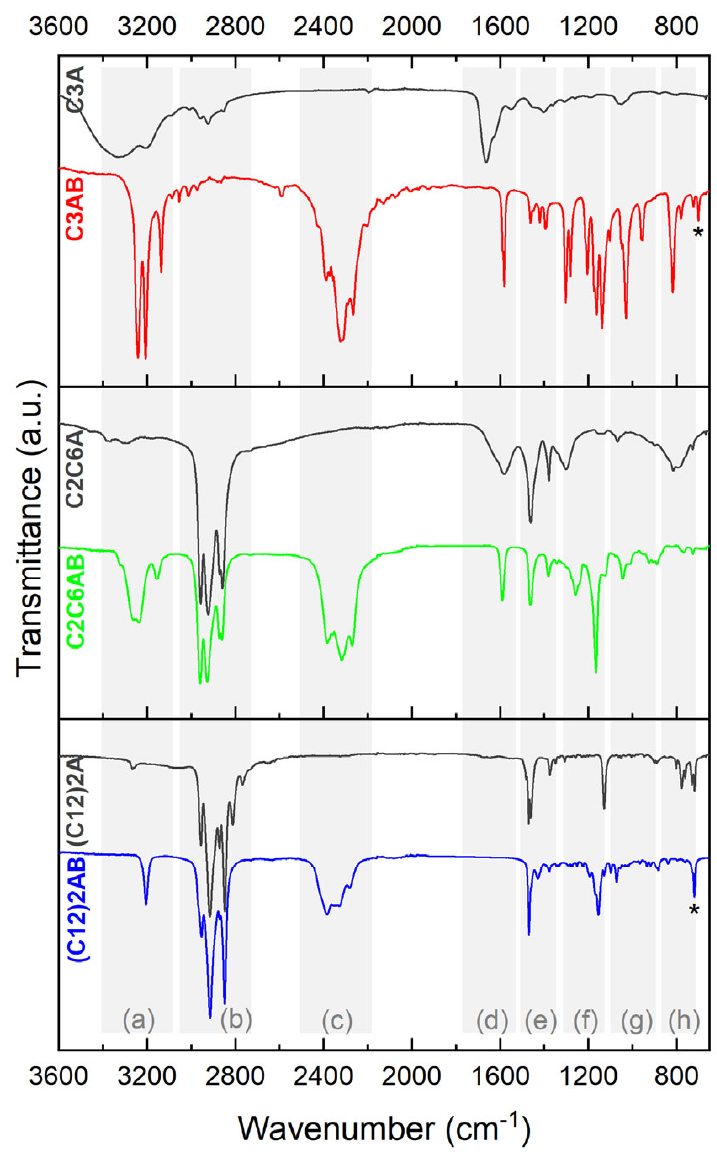
Figure 4. FTIR spectra of C3AB, C2C6AB and (C12)2AB. The spectra of the starting amines C3A,